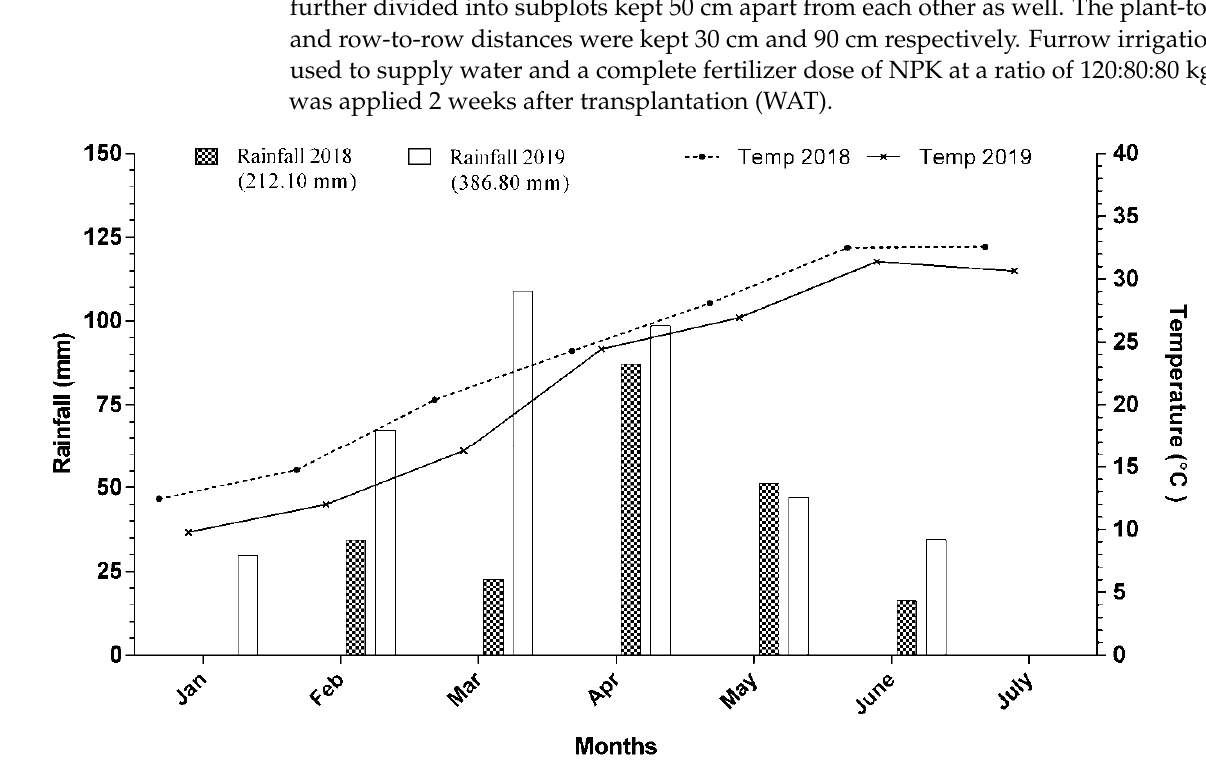
Figure 2. Monthly mean Rainfall (mm) and temperature (°C) of the study area.